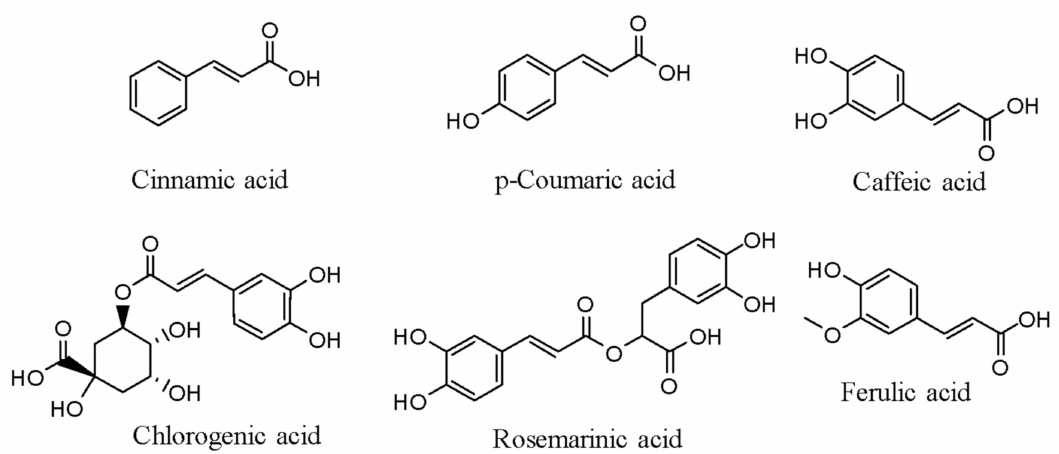
Figure 1. Chemical structures of a few phenolic